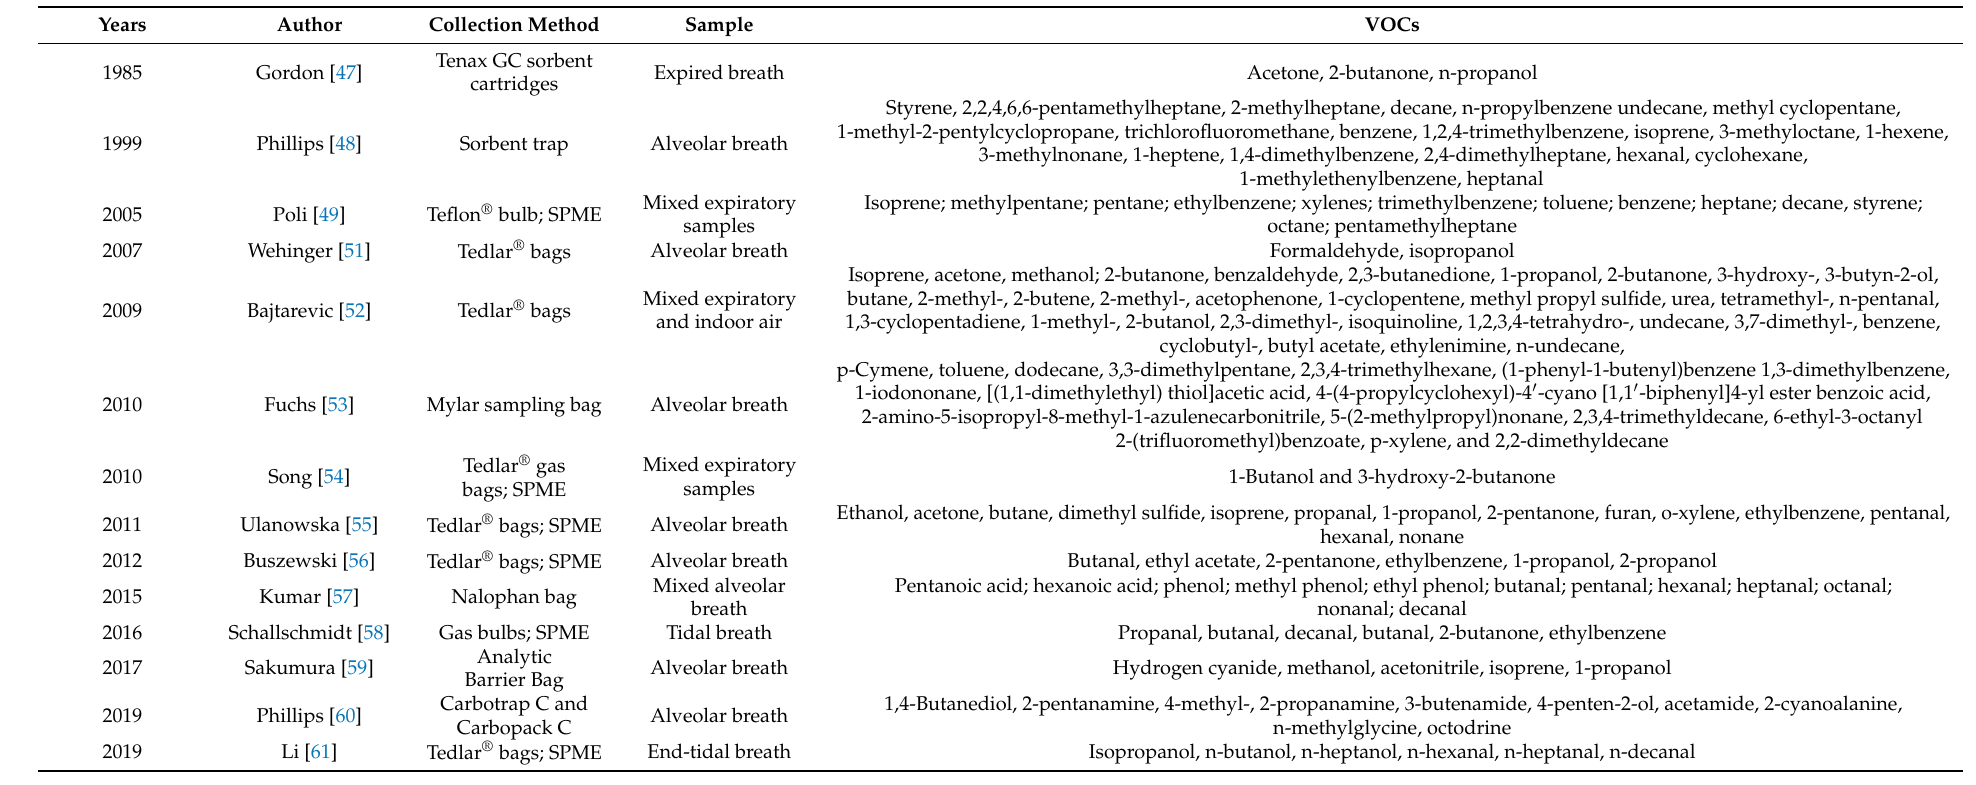
Table 1. Reported exhaled VOC markers for the early screening of lung